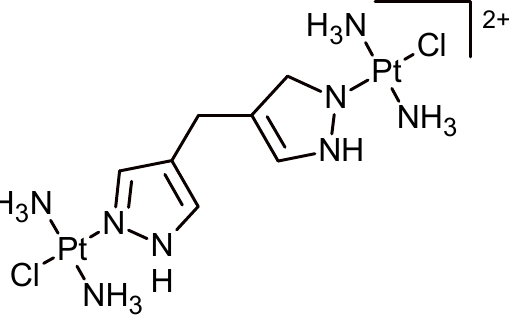
Figure 11. Chemical structure of dinuclear platinum complex trans-[[PtCl(NH 3 ) 2 ] 2 µ-dpzm] 2+ .